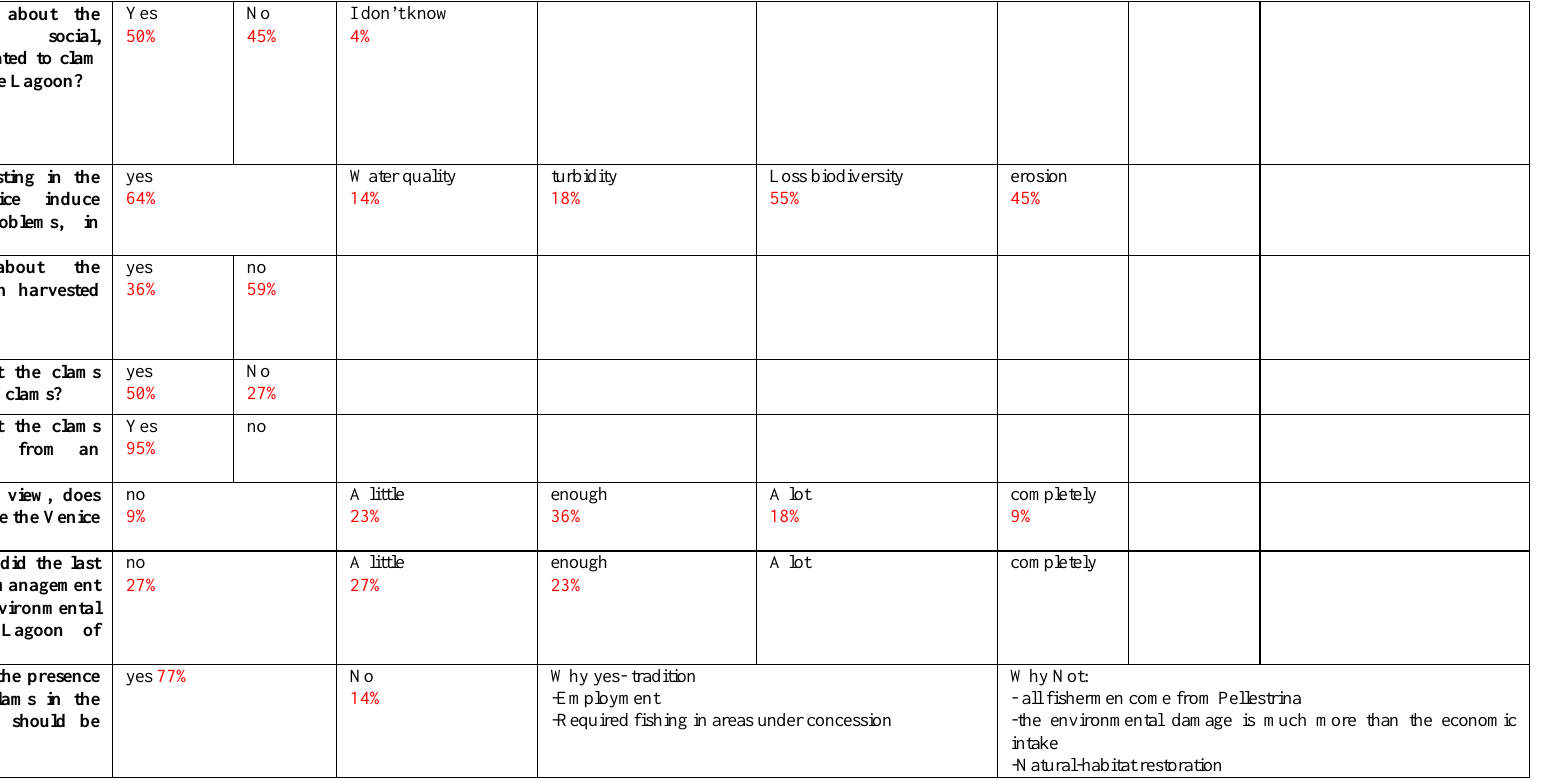
Table A1. Results of the questionnaire submitted to the association of consumers in order to explore consumer perception of clam farming